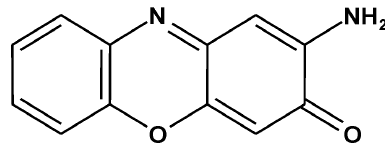
Figure 1. Chemical structure of